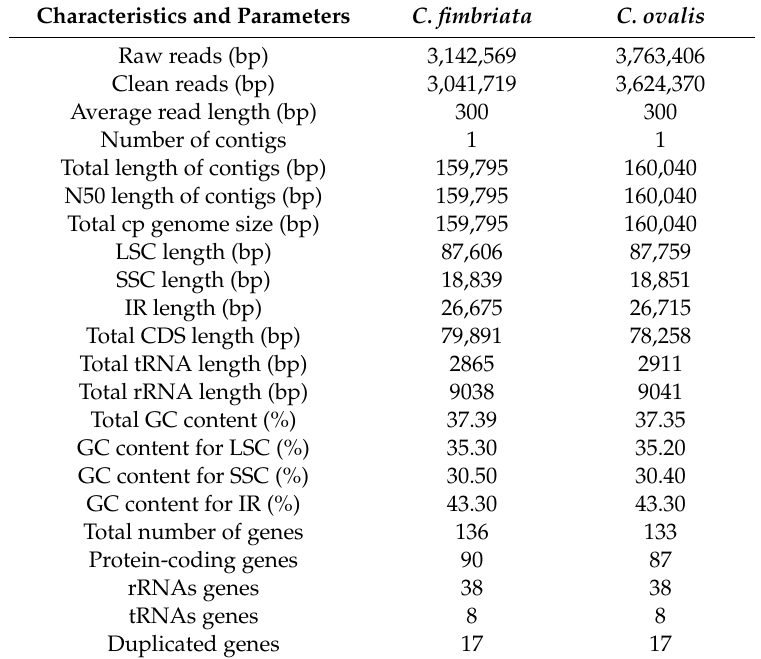
Table 1. Characteristics and Basic Assembly Parameters of Two Coelogyne Chloroplast Genomes.